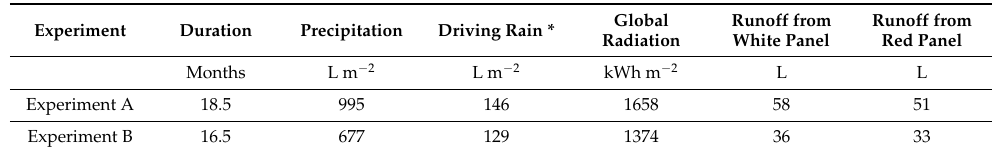
Table 2. Total precipitation, driving rain, global radiation, and runoff from the test panels during the experiments. Experiment Duration Precipitation Driving Rain * Global Radiation Runoff from White Panel Runoff from Red Panel Months L m − 2 L m − 2 kWh m − 2 L L Experiment A 18.5 995 146 1658 58 51 Experiment B 16.5 677 129 1374 36 33